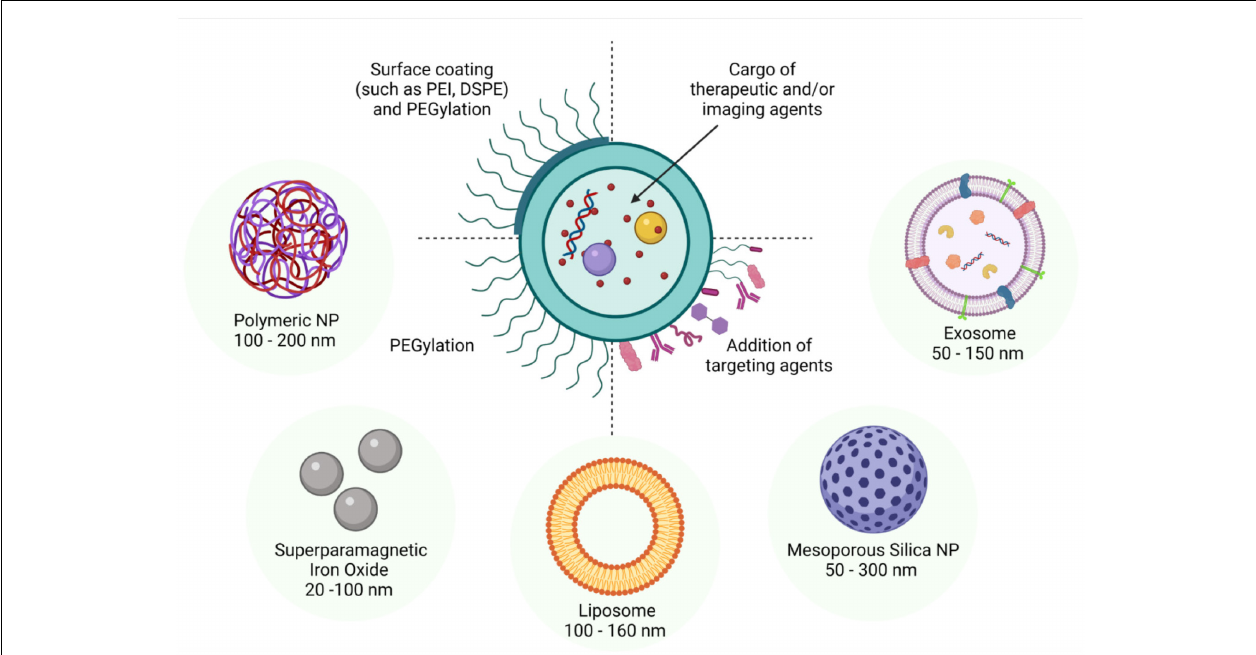
FIGURE 2 | Schematic diagram of some of the more commonly studied nanoparticles highlighting their adaptability for drug encapsulation and surface modification. In line with a spectrum of different applications, such nanoparticles have been formulated to encapsulate cargo as diverse as proteins, peptides, drugs and nucleotides. Similarly, tailored surface coatings can include molecules such as PEG, which confers improved in vivo stability, as well as targeting agents such as antibodies, peptides, proteins, and aptamers. The dimensions of the nanoparticles can also be varied through the application of different preparation techniques and surface modifications; with the size range of 90 nm - 120 nm being optimal for facilitating particle uptake via cellular endocytotic pathways. Alternatively, small lipophilic particles can enter the target cell via direct penetration of the membrane while those particles larger than 500 nm generally gain entry via